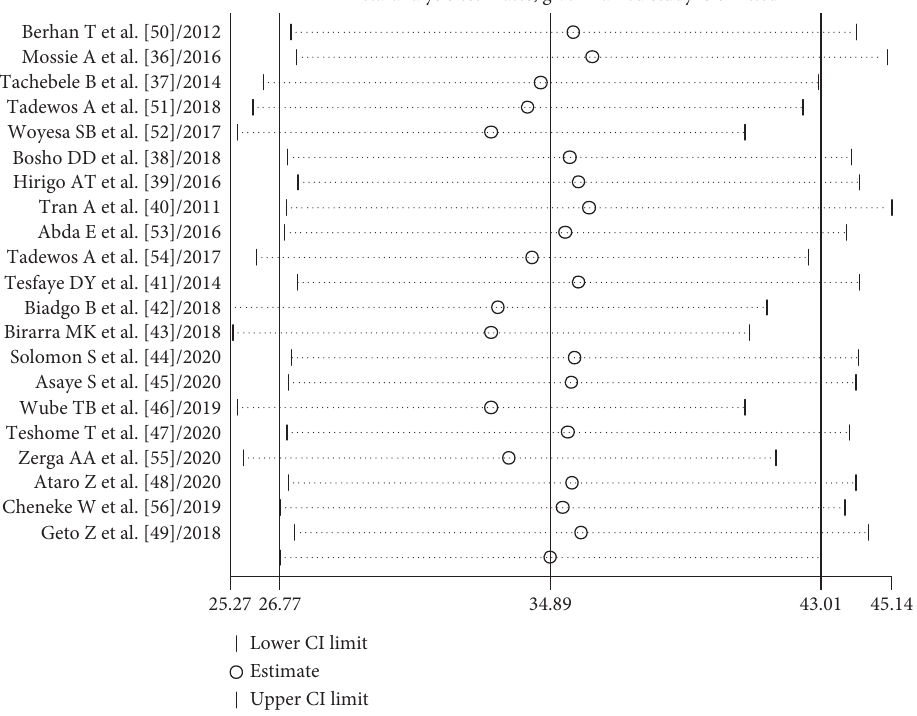
Figure 6: Sensitivity analysis based on NCEP/ATP III criteria.